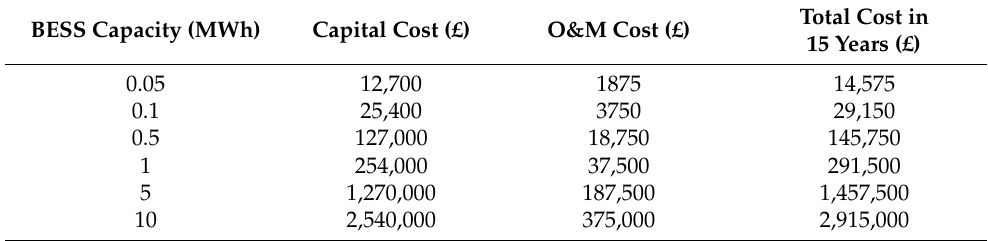
Table 4. Total cost of BESS for a lifetime of 15